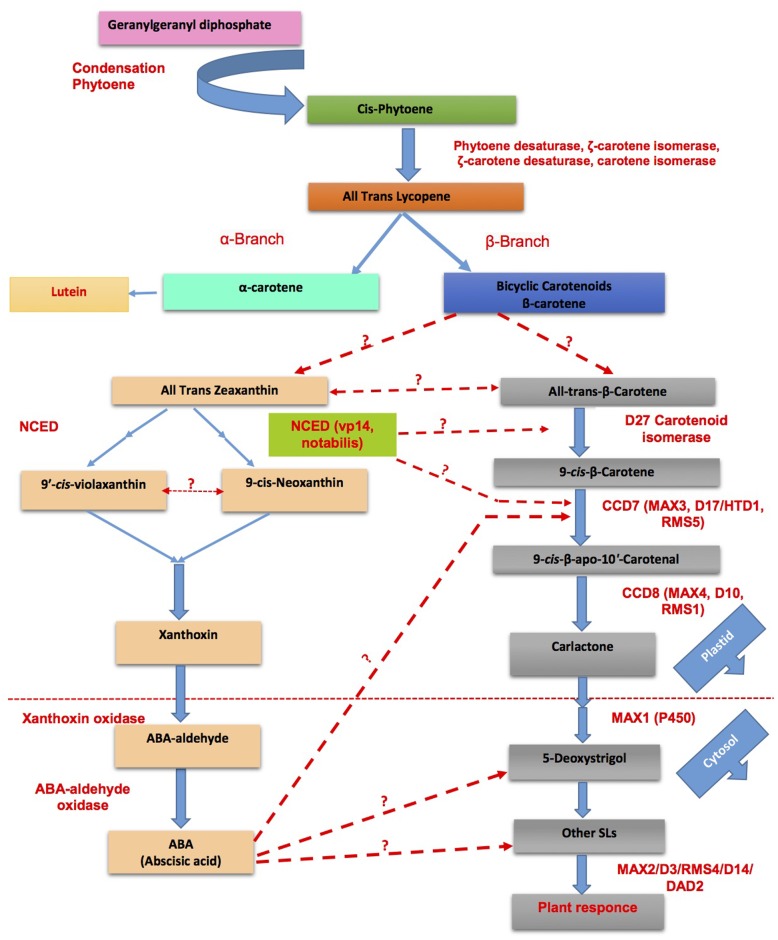
Cross talk between SLs and abscisic acid (ABA) biosynthesis for the adaptability of plants in response to challenging environmental conditions (modified from Ruyter-Spira et al., 2013; Zhang et al., 2013). Dotted lines represent the unexplored/partially explored interactions.